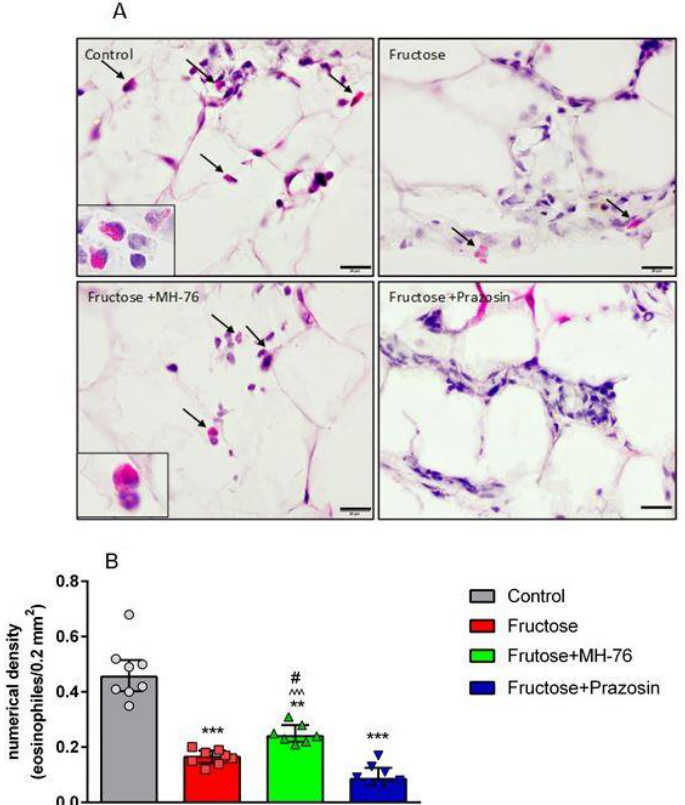
Figure 9. ( A ) Representative photomicrographs of abdominal adipose tissue with eosinophils (arrows and enlarged boxes) in the different groups of rats. The increase in eosinophil count in Fructose + MH-76 adipose tissue are visible. Hematoxylin and eosin stain, bar = 20 µm. ( B ) Numerical density (median +IQR) of eosinophils per 0.2 mm 2 cross section area of abdominal adipose tissue from the Control, Fructose, Fructose + MH-76 and Fructose + Prazosin rats. ** p < 0.01, *** p < 0.001 versus Control, # p < 0.05 versus Fructose, ^^^ p < 0.001 versus Fructose + Prazosin, (Kruskal–Wallis test by ranks, post hoc Dunn test).